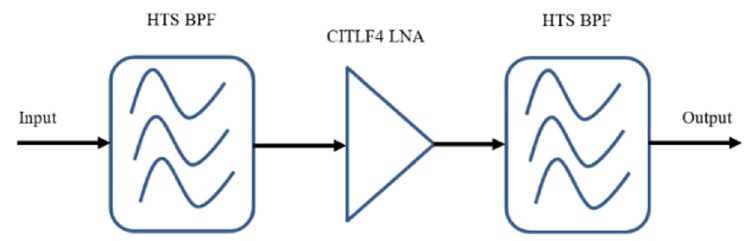
Figure 5. RF front-end block diagram with HTSC filters.